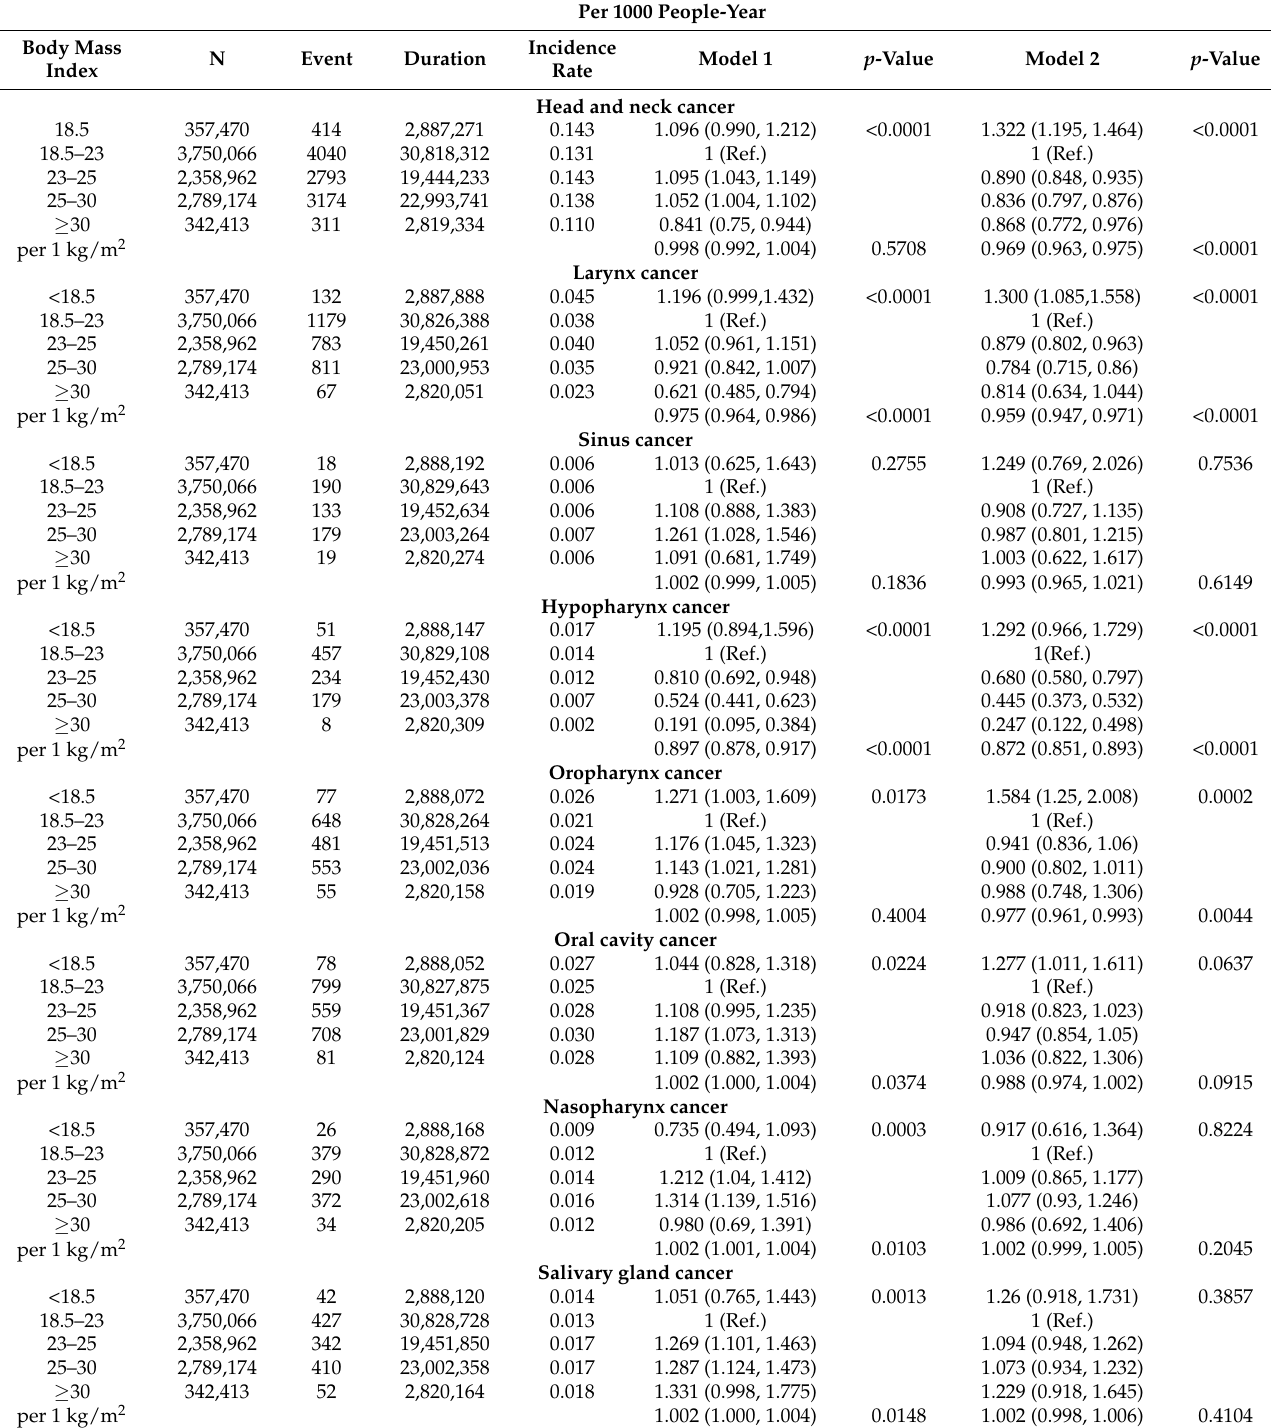
Table 2. Hazard ratios of head and neck cancer and its subtypes according to body mass index level. Per 1000